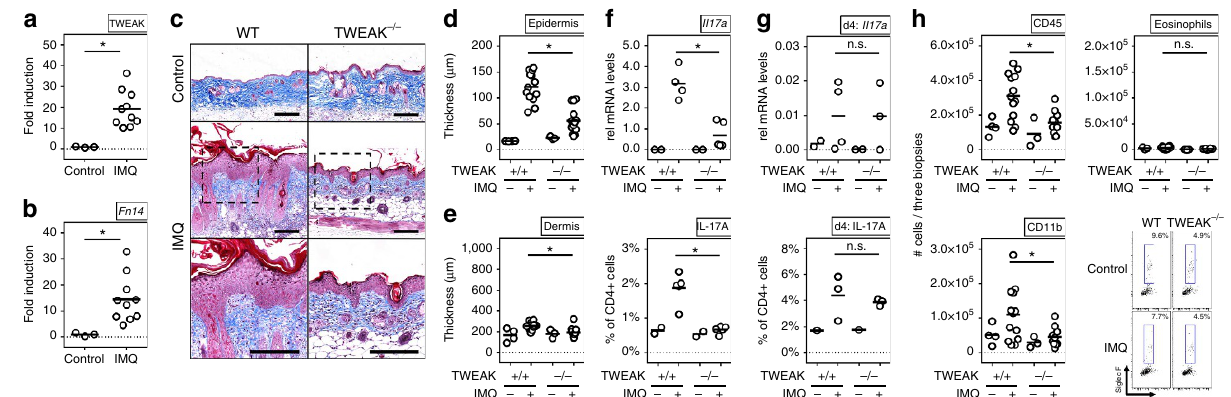
Figure 2 | Reduced disease severity in IMQ-induced psoriasis in the absence of TWEAK. WTand TWEAK-deficient mice were treated epicutaneously on the shaved back with IMQ for 8 days to induce psoriasis-like disease. ( a , b ) TWEAK and Fn14 mRNA fold induction in WTmice relative to expression in skin from naive animals (control). Combined results from three experiments. Each data point an individual mouse. ( c ) Representative Masson’s trichrome staining of skin sections. Scale bar, 200 m m. ( d , e ) Epidermal and dermal thickness on day 8 measured on trichrome-stained sections. ( f , g ) IL-17 mRNA in skin lesions and frequency of IL-17 positive CD4 þ T cells in skin-draining lymph nodes on day 8 ( f ) or day 4 ( g ). Each datapoint one mouse. ( h ) Total numbers of CD45 þ cells (left top), CD45 þ CD11b þ monocytes (left bottom) and SigF þ CD45 þ CD11b þ Ly6G (cid:2) eosinophils (right) from skin biopsies obtained on day 8. Combined results from three experiments. Each data point one animal. Bars represent mean values. The Mann–Whitney U -test was performed to compare the groups. Asterisks indicate P o 0.05. n.s. indicates nonsignificant differences.